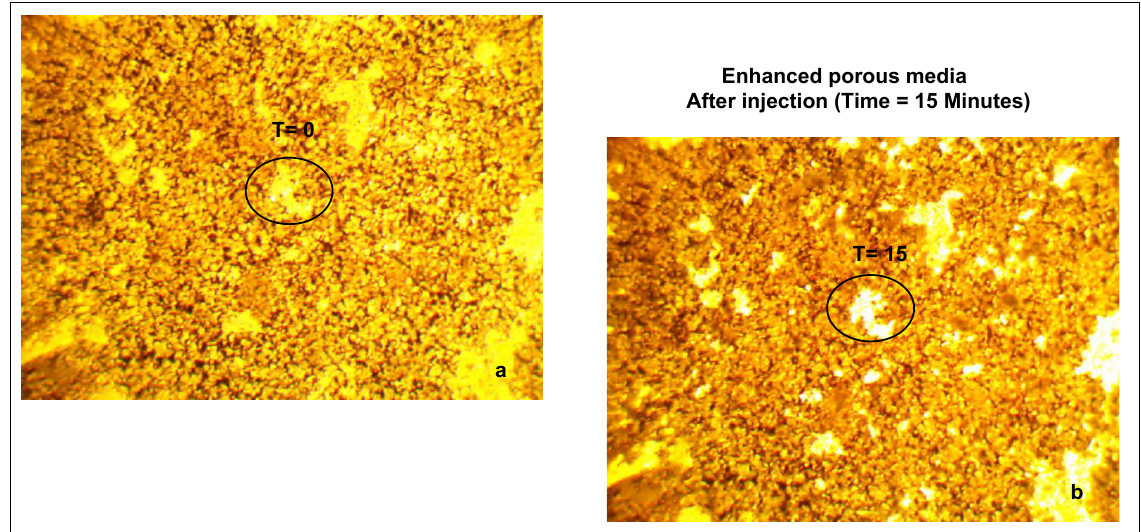
Figure 6. Microphotographs illustrate ( a ) fine–coarse crystalline dolomite with numerous vugs floating within dominant dolostone microfacies under normal conditions (t = 0), ( b ) the same dolostone microfacies in ( a ) but after in-situ acid injection (when t = 15 min). The alteration influenced the calcite crystals (close-up, the dark circle) more than the dolomite crystals; the final result is an enhancement of the porous media due to in-situ acid injection.